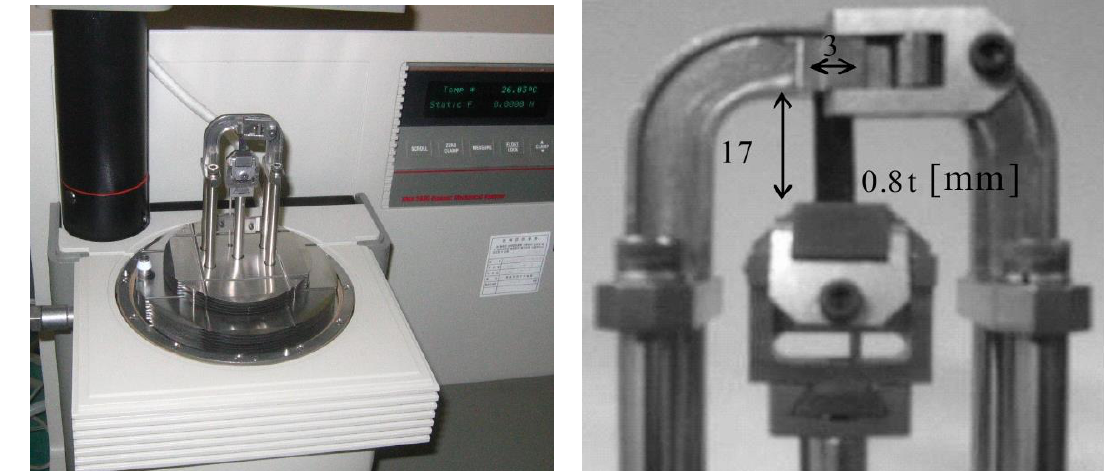
Figure 5. Experimental setup for the static tension test.